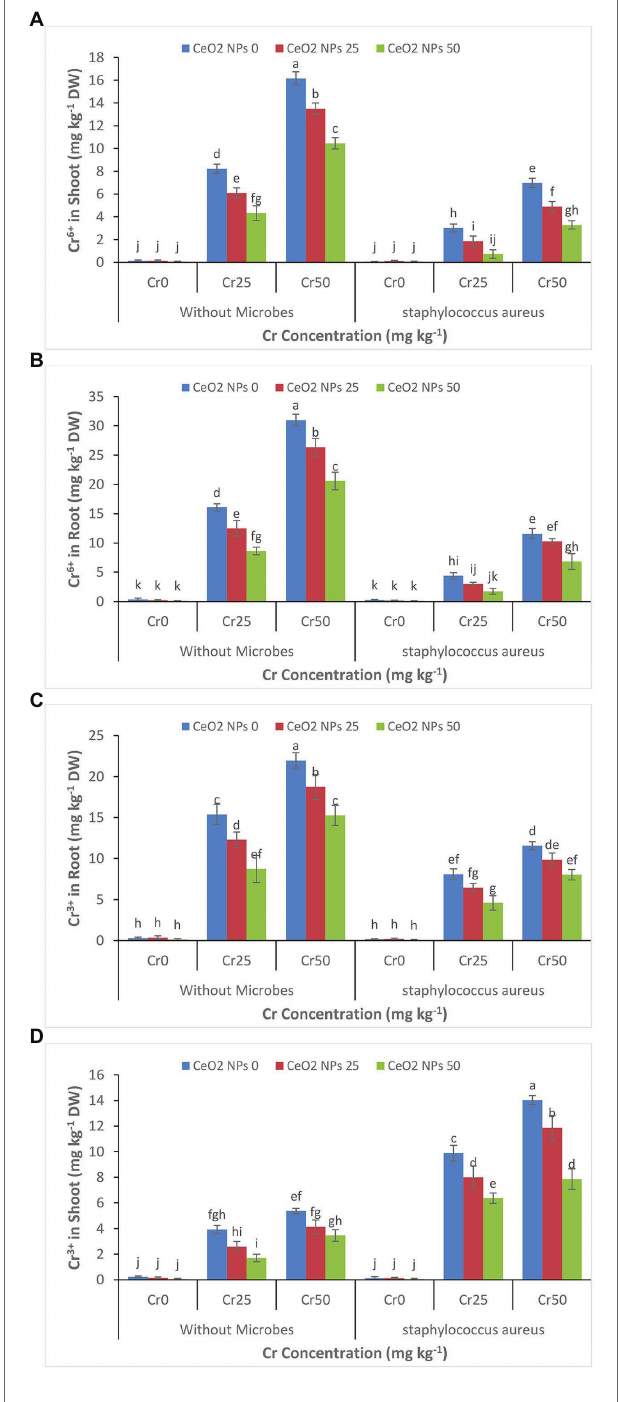
FIGURE 6 | (A–D) : Effect of CeO 2 NPs and Staphylococcus aureus on bioaccumulation of Cr +6 in the shoot (A) , Cr +6 in roots (B) , Cr +3 in the shoot (C) , and Cr +3 in roots (D) of sunflower plant under Cr stress. The given values are means of three replications with standard deviation. The alphabets represent the significant/non-significant difference at p ≤